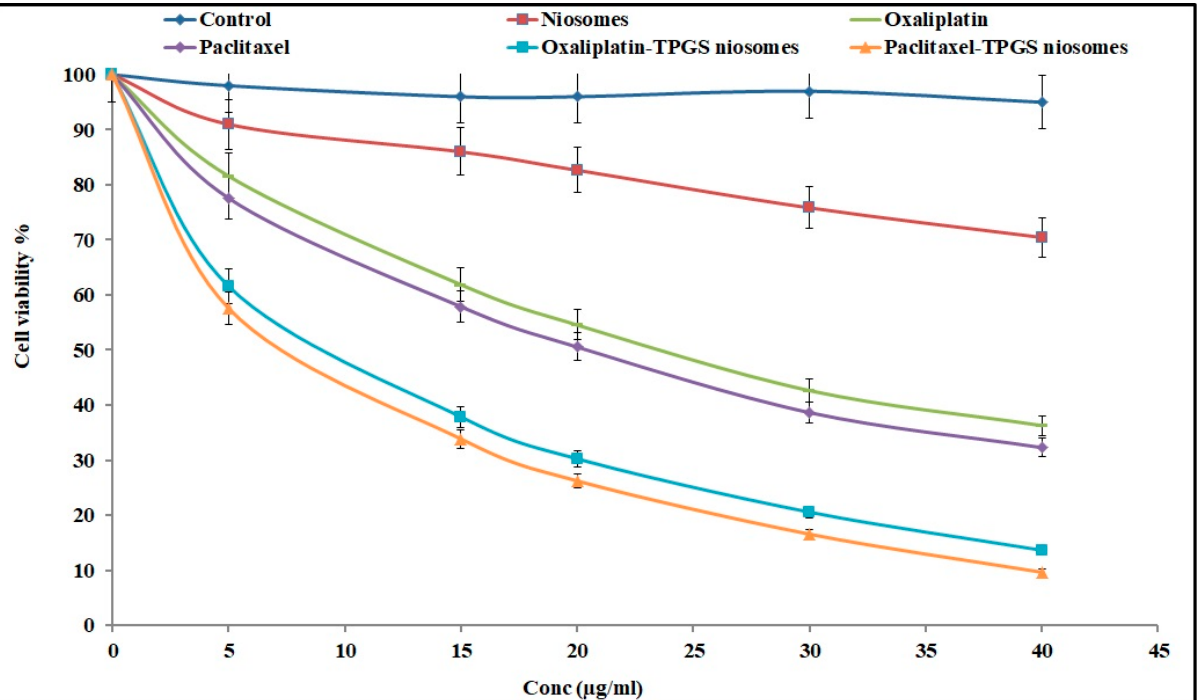
Figure 6. The cytotoxic effect of Oxaliplatin–TPGS–niosomes, Paclitaxel–TPGS–niosomes, drug-free niosomes (F9), Oxaliplatin solution and Paclitaxel solution at various concentrations against HT-29 cells for 24 h (n = 3, mean ± SD) ( p < 0.05 ).